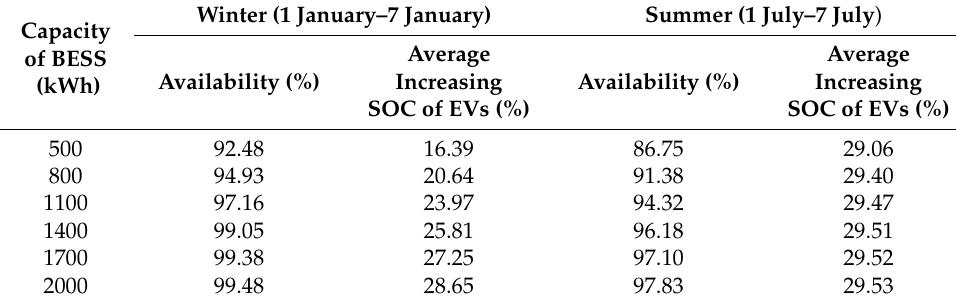
Table 6. Analysis with 50% initial SOC of BESS.